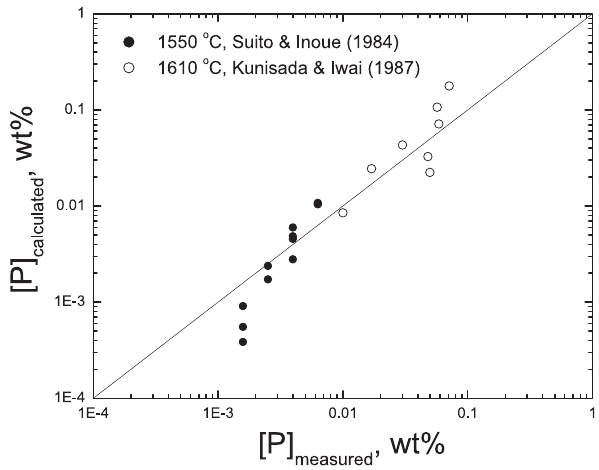
Fig. 7: Comparison of the model calculated P concentration in the liquid iron equilibrated with the Na with the experimental data [24,